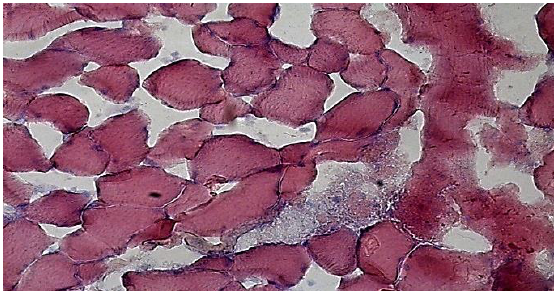
Fig. 4. Striated muscle tissue of the control samples of the refrigerated pork neck on the bone packed using MAP and irradiated at a dose of 12 kGy.